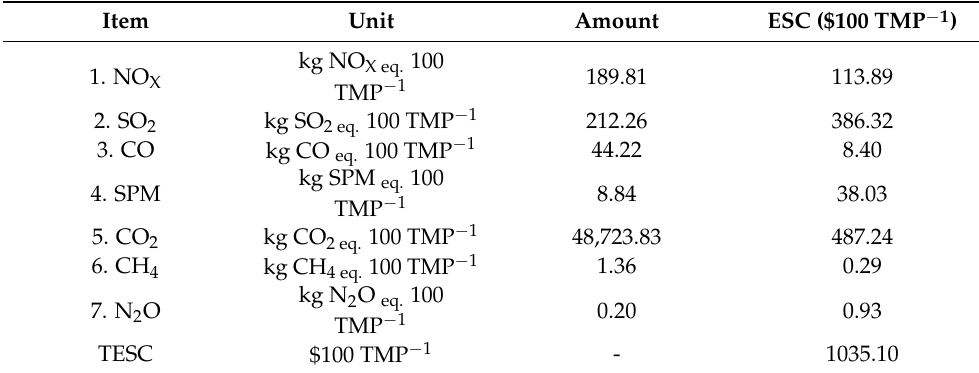
Table 6. ESC results for 100TMP in Isfahan province, Iran.